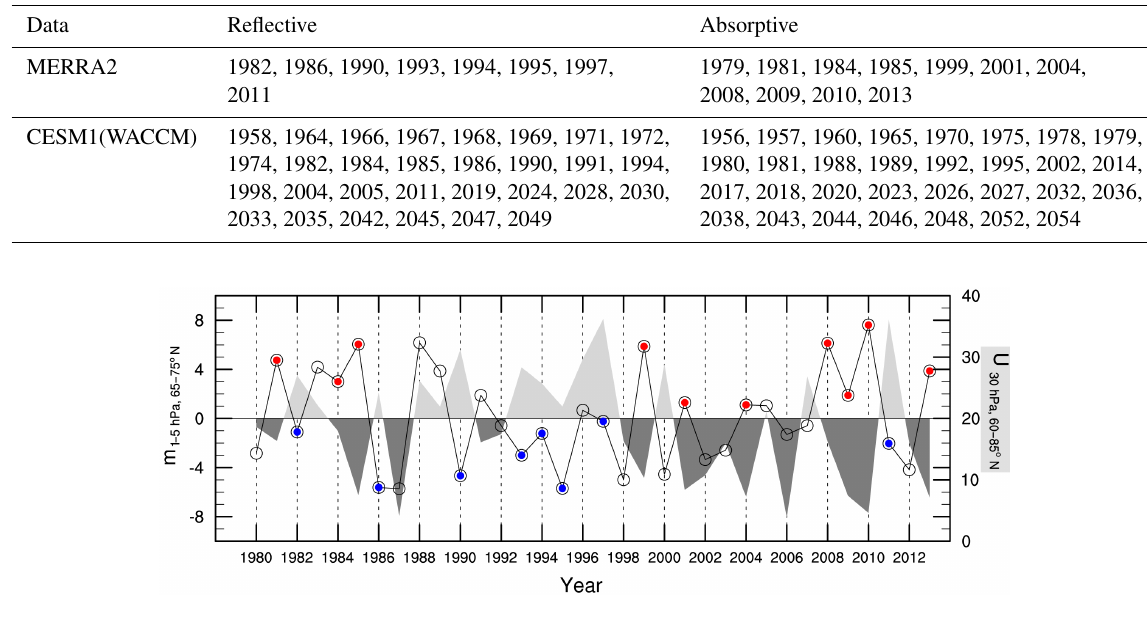
Figure 9. Time series of seasonal (JFM) mean of m (line) and U30 (shading). The blue (red) asterisk indicates the reflective (absorptive) winters defined based on vertical wave numbers and mid-stratosphere zonal mean wind (further discussed in the